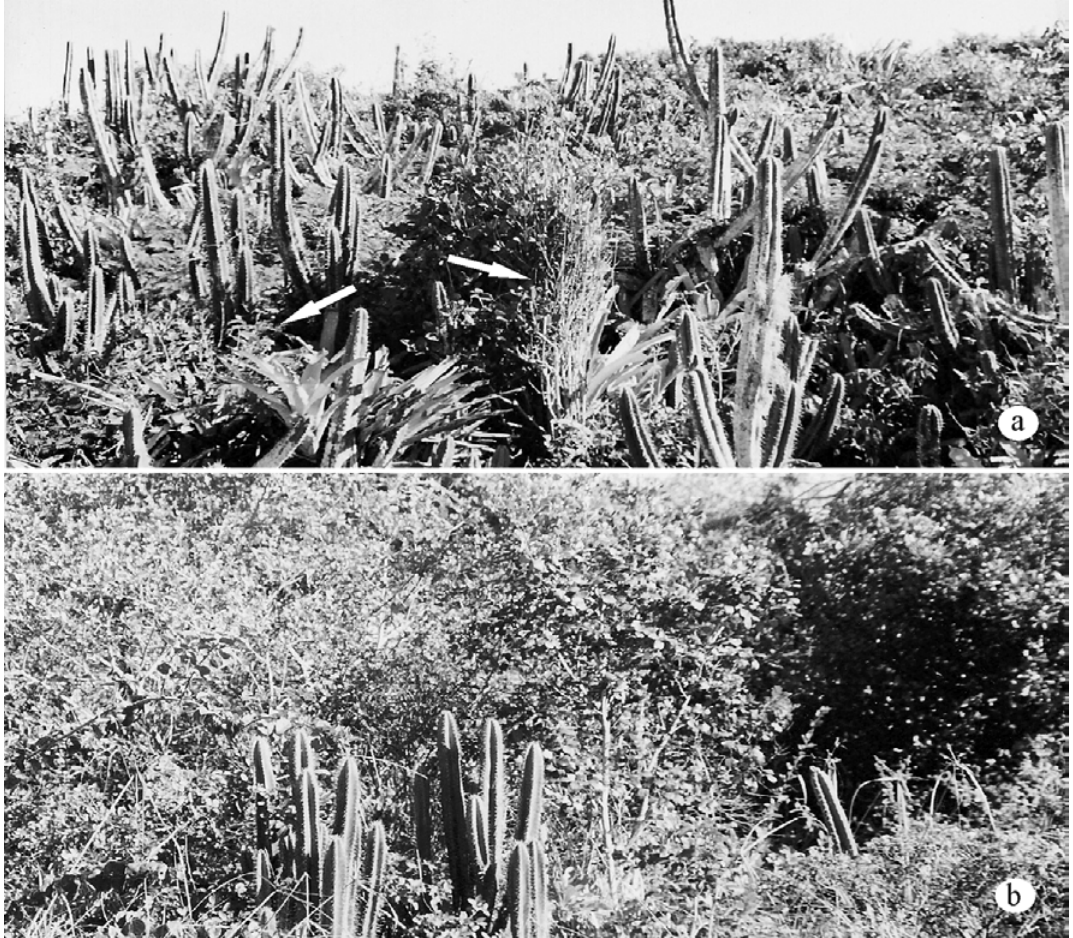
Fig. 1 – a. Aspect of the Open Palmae Shrub (OPS), individuals of Mollinedia glabra (arrows). b. Aspect of the Shrubby Vegetation